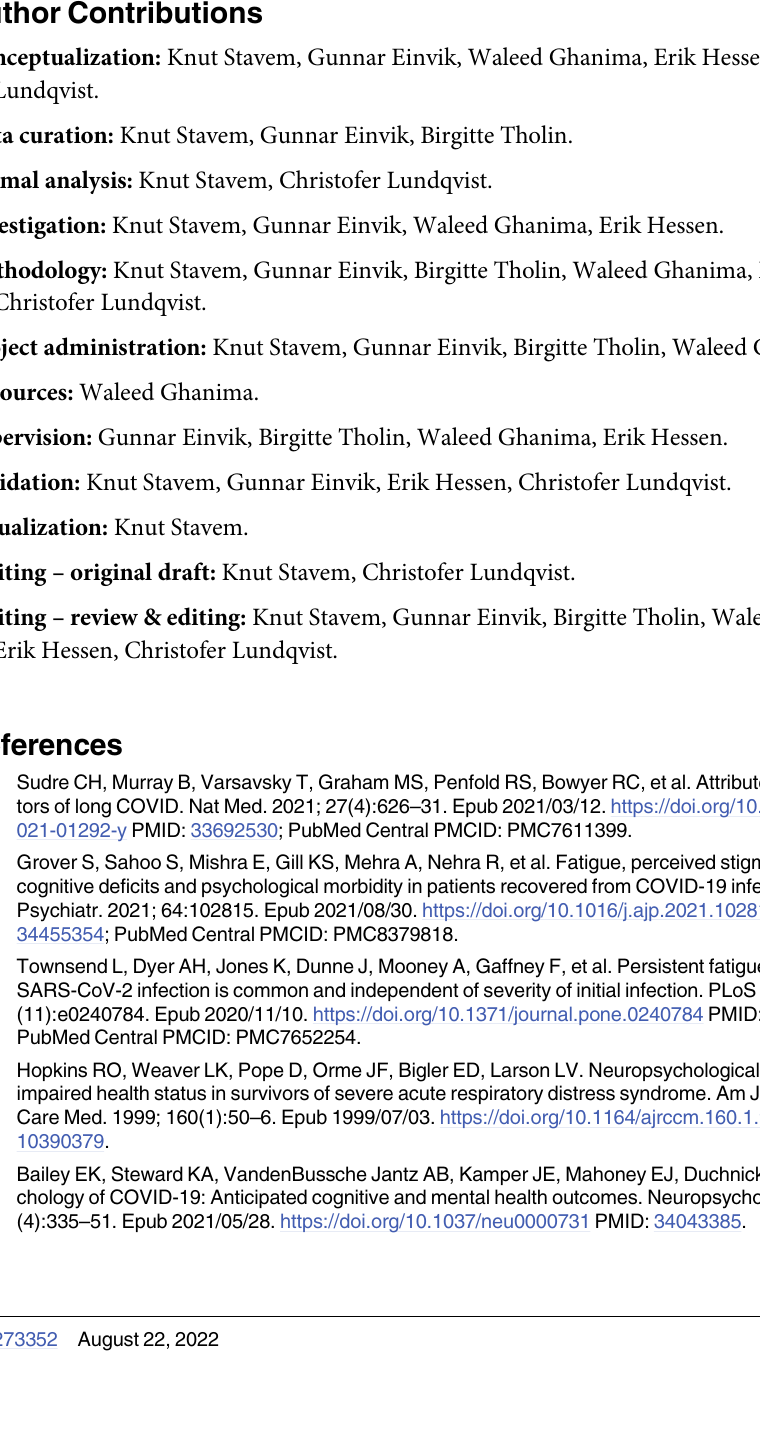
S1 Table. Non-response analysis among those that responded to the first survey (n = 458). Comparison between those completing CANTAB assessment during the follow-up visit (n = 233) and non-participants/not responding to CANTAB (n = 225). S2 Table. Cognitive test scores for subjects � 60 years and comparison with norm popula-